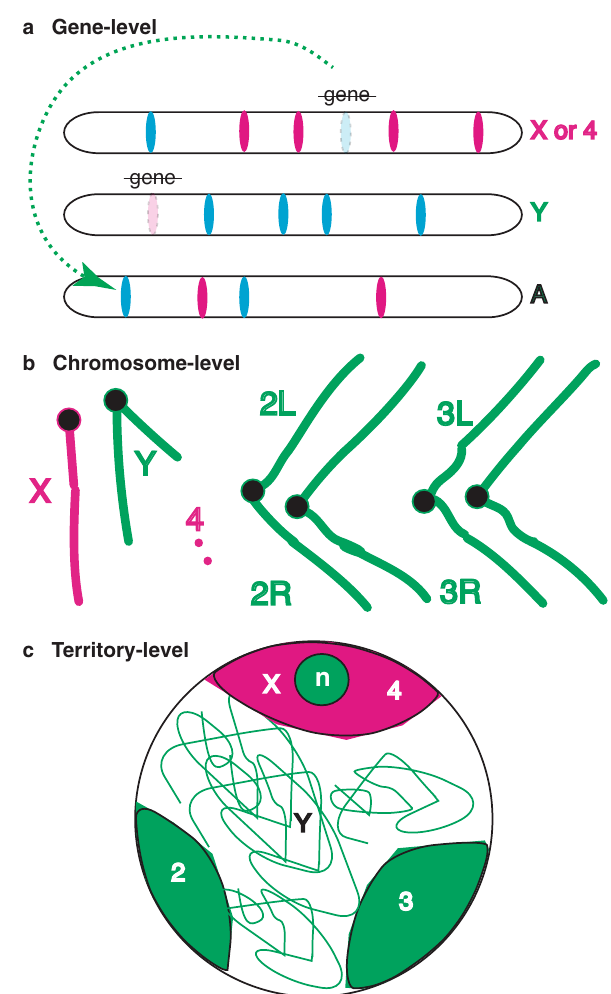
Fig. 7 Models for chromosome element expression in